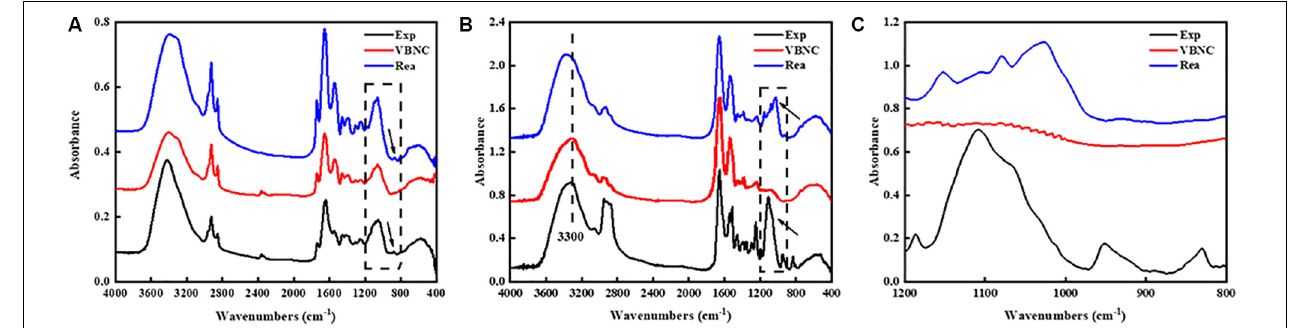
FIGURE 4 | FT-IR spectrum of (A) R. biphenylivorans TG9 cells in the exponential phase, the VBNC state, and after resuscitation, the differences in the spectra of bacteria in different states in the 1200–800 cm − 1 region which as shown by the arrow and vertical rectangle. (B) peptidoglycan and Characteristic peak of peptidoglycan were shown by the vertical rectangle and vertical dashed line, (C) peptidoglycan in 1200–800 cm − 1